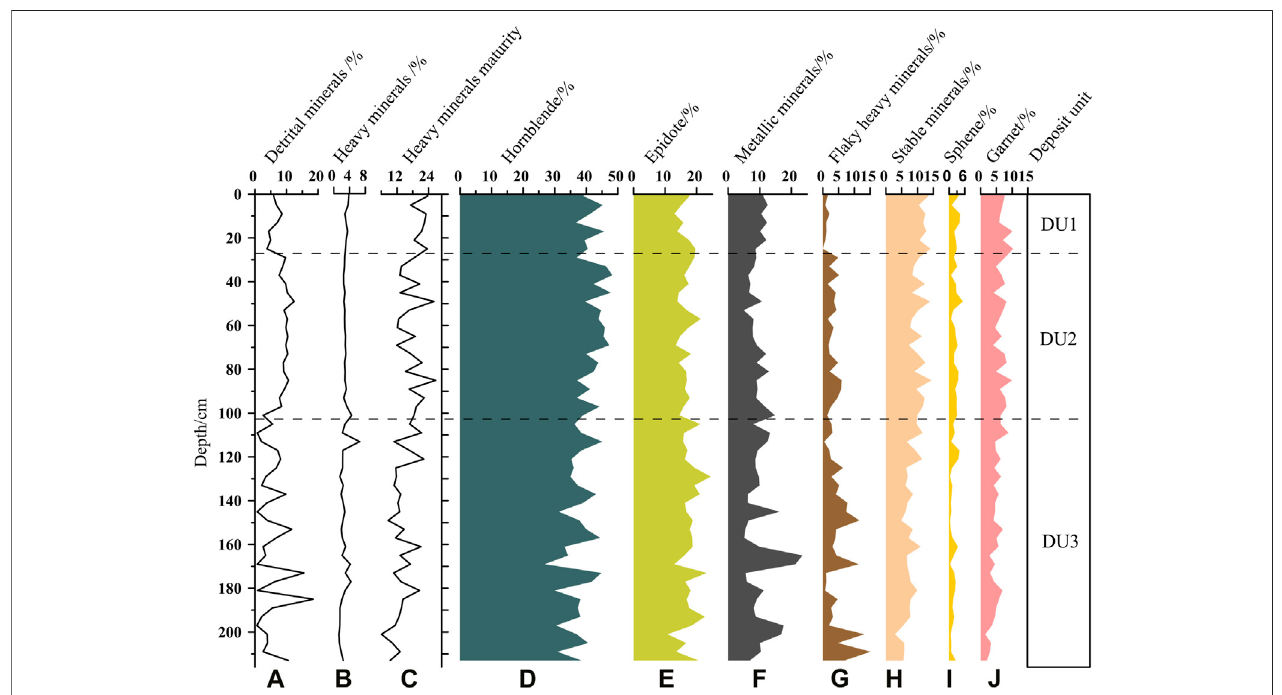
FIGURE 4 | Depth versus major heavy minerals content (A – J) in core H10 (detailed data in Supplementary Table S2 ).